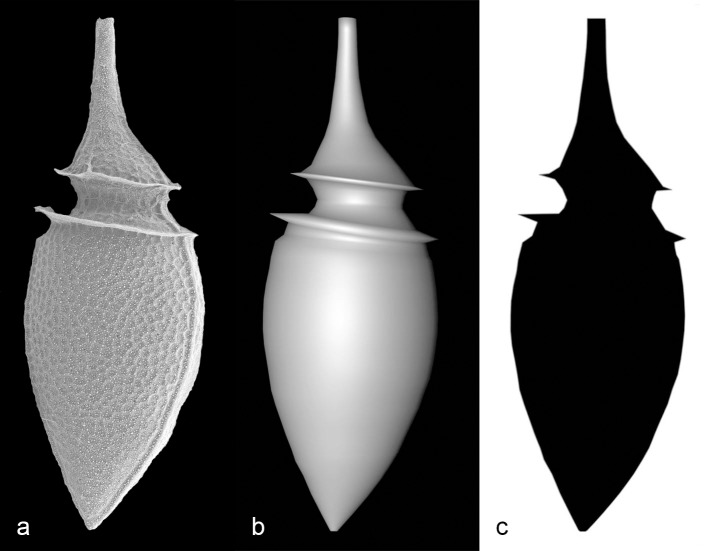
3D model of Oxyphysis oxytoxoides, a heterotrophic dinoflagellate species common in temperate to subtropical waters.(a) Scanning Electron Microscope picture of an individual of Oxyphysis oxytoxoides, (b) Binary picture obtained through image segmentation of a, and employed for the estimation of the cross-sectional surface area of the cell, (c) 3D reconstruction of a cell of O. oxytoxoides using a as a model.